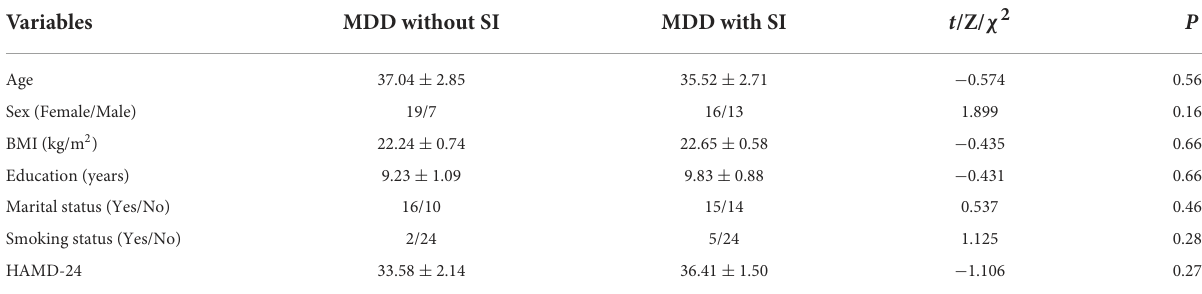
TABLE 1 Demographic and clinical characteristics of MDD patients without SI and MDD patients with